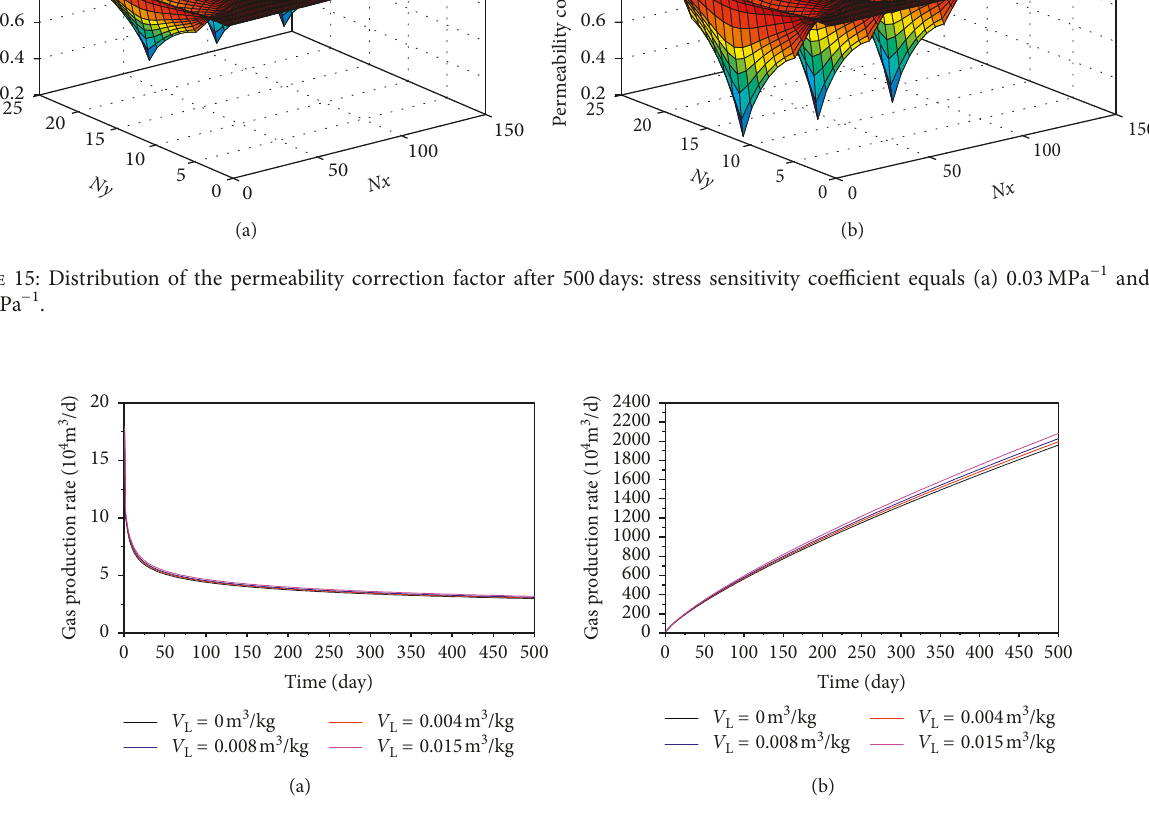
Figure 16: Effect of Langmuir volume on behavior of the multistage fractured horizontal well: (a) gas production rate; (b) cumulative gas production.